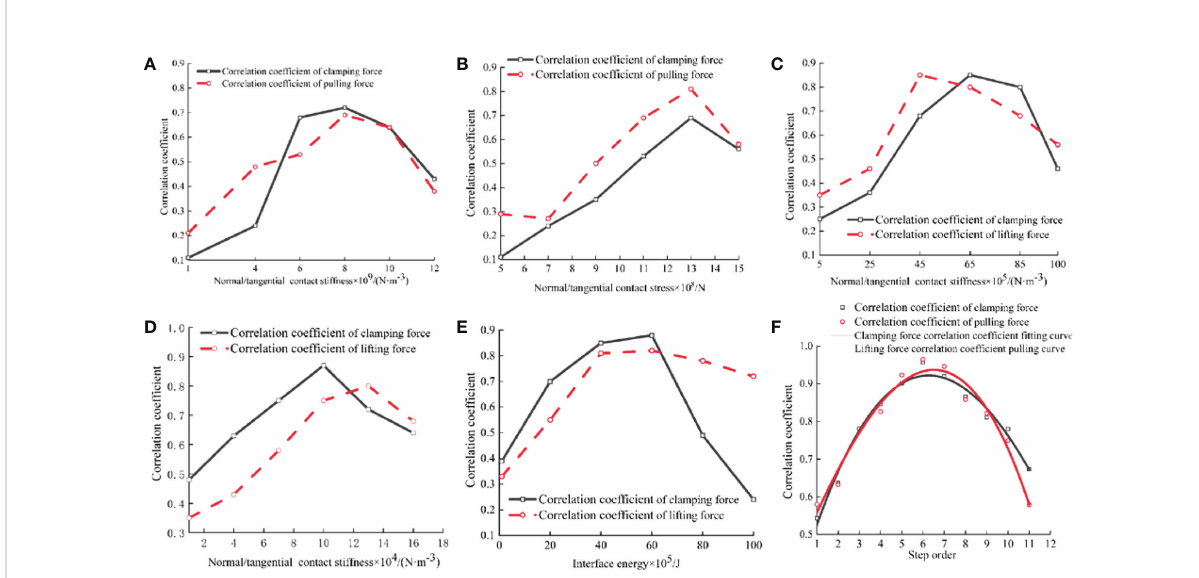
FIGURE 7 Results of Single factor and Plackett-Burman simulation experiments. (A) Changes of RC and RL at different X1 levels; (B) Changes of RC and RL at different X2 levels; (C) Changes of RC and RL at different X3 levels; (D) Changes of RC and RL at different X4 levels; (E) Changes of RC and RL at different X5 levels; (F) Fitting plot of step order and correlation coef fi cient.